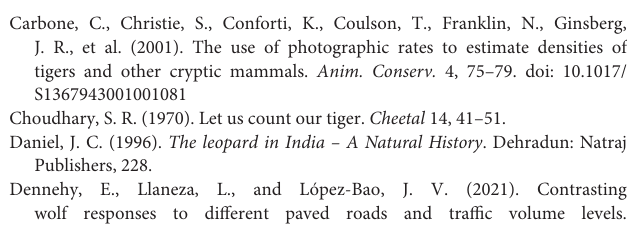
Supplementary Figure 1 | Relationships of wolf occurrence with eco-geographical variables when all variables were considered together in the model and with variables that were considered in explaining wolf occurrence but not used in the final model. Supplementary Figure 2 | Three-dimensional and two-dimensional scatter plots of wolf relative abundance index (RAI) against tiger (B,C) , leopard (A,B,D) , and dhole (A,E) . Two-dimensional scatter plots show intensity and 95% ellipses of data distribution. Wolf RAI was negatively correlated with all three large carnivores but was statistically significant ( p < 0.01) only for